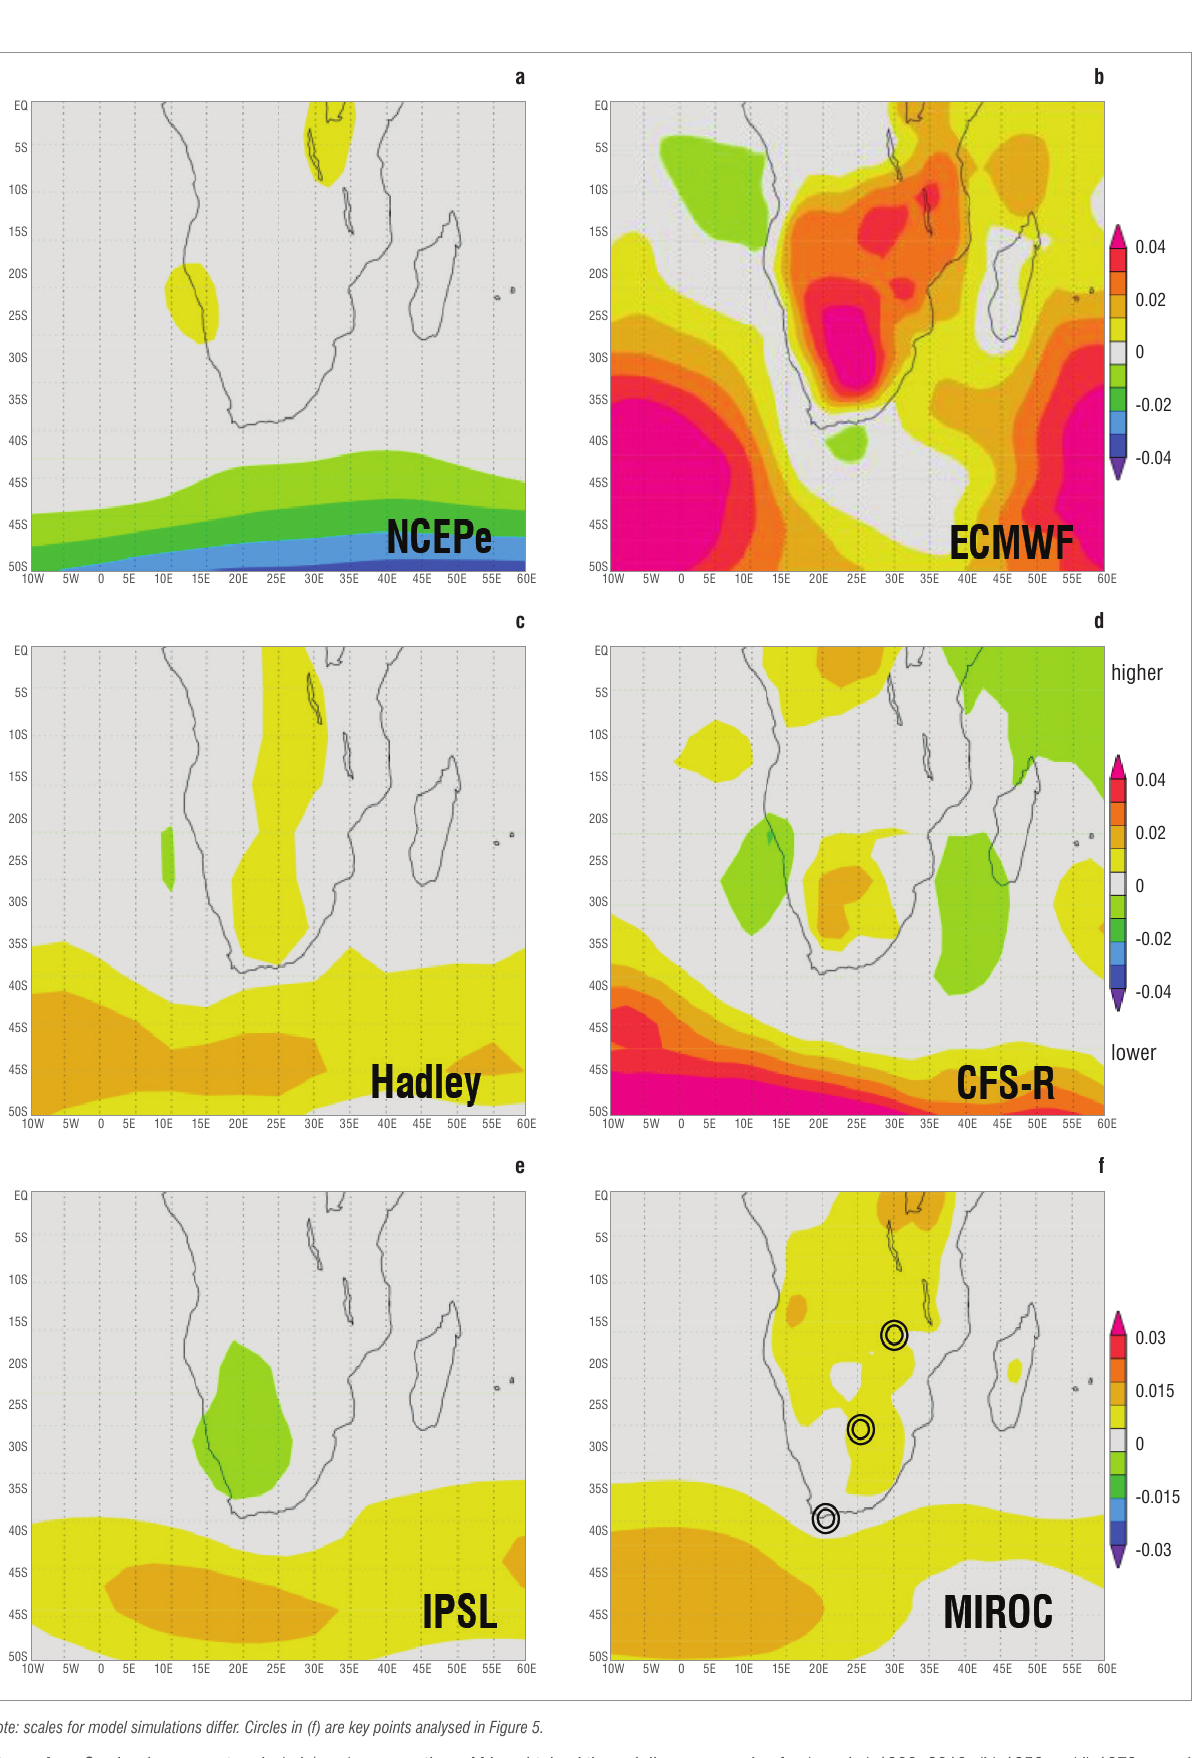
South African Journal of Science http://www.sajs.co.za